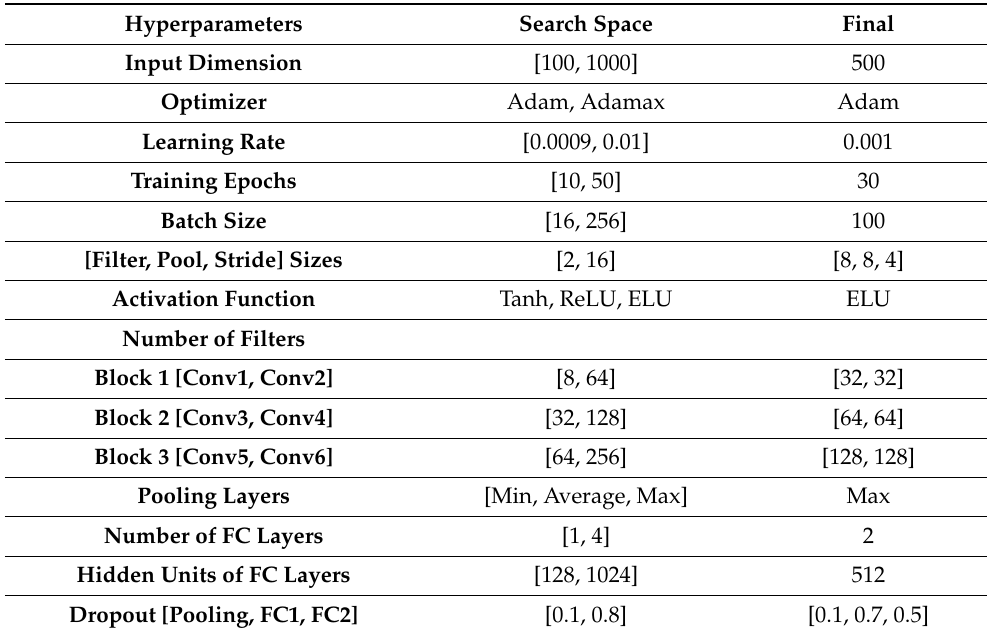
Figure 3. Block diagram of the proposed CNN model. Table 2. Hyperparameters search space and final values for the CNN